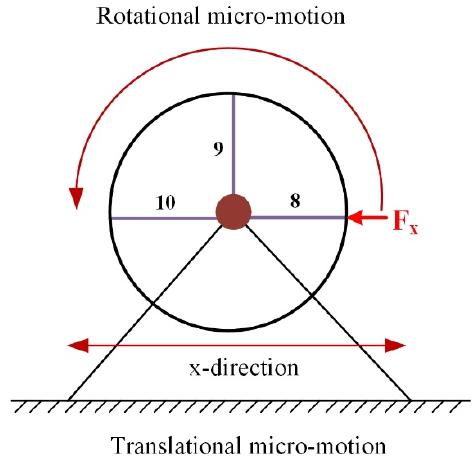
Figure 4. Schematic of moving principles of the flexible bearing hinges (FBHs) mechanism.